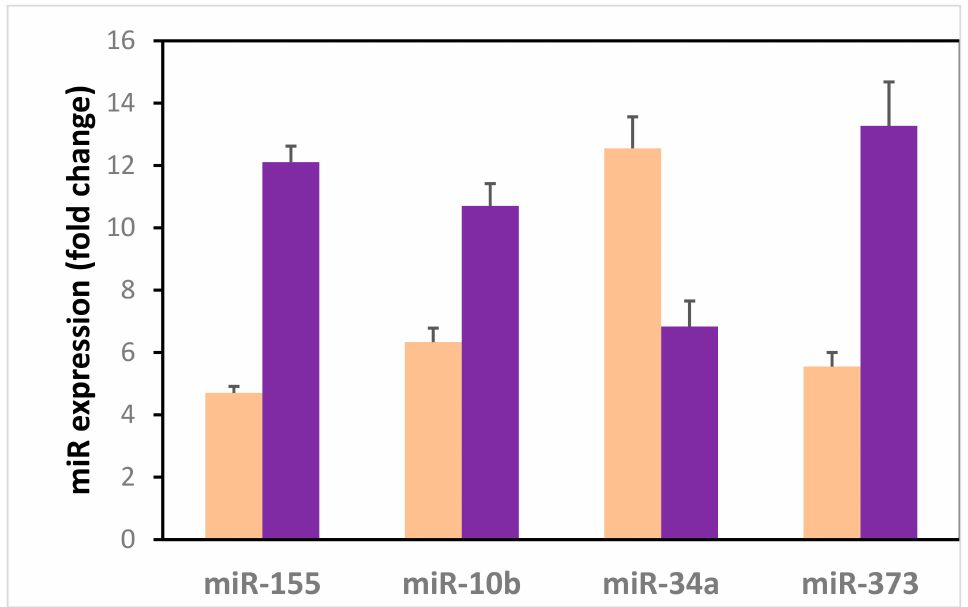
Figure 2. Circulating serum microRNAs in the non-metastatic BC group in contrast to the control group. Control group BC